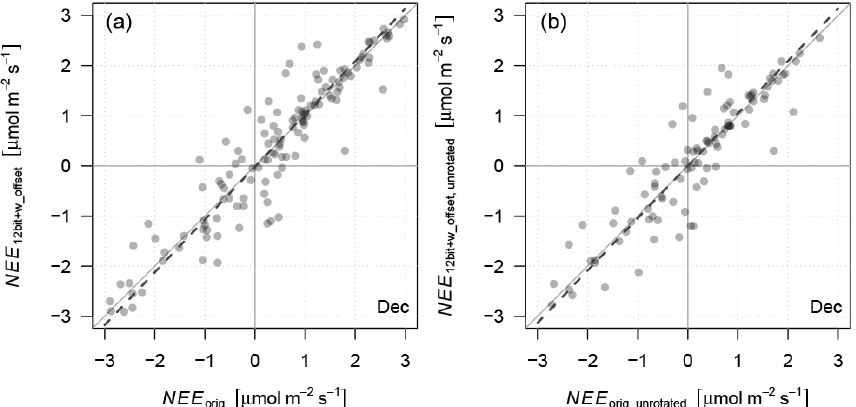
Figure 5. Comparison of the original NEE measurements at the Waldstein-Weidenbrunnen site in December 2012 (original 16bit digi- talization) with synthetic data with 12bit digitalization for the gas analyser and the instrument error ( w offset) of the sonic anemome- ter R2. (a) The data were rotated (compare with Fig. 4b, NEE 12 bit_w_offset = 1 . 052 NEE org , R 2 = 0 . 87, N = 129) and in (b) were not (NEE 12 bit_w_offset_unrotated = 1 . 045 NEE org_unrotated , R 2 = 0 . 83, N = 97). Only data smaller than | 0 . 003mmolm − 2 s − 1 | are shown.